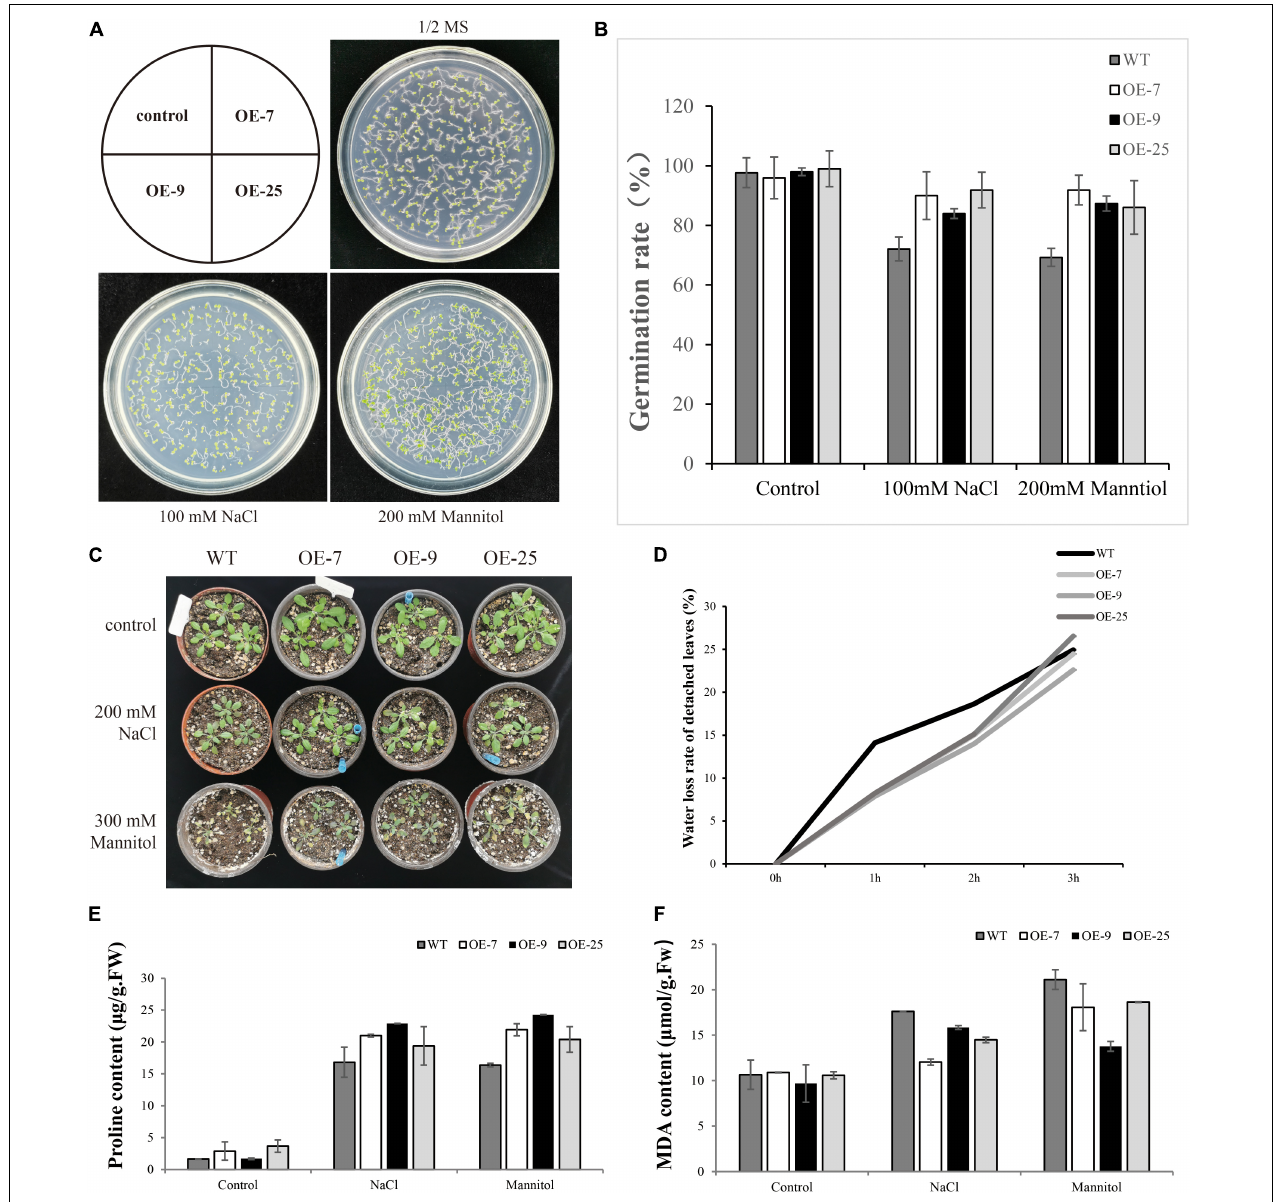
FIGURE 5 | Seed germination assays in mature seeds of WT (WT) and BpMYB4-OE lines (OE-7, OE-9, and OE-25). (A) Germination of WT, OE-7, OE-9 and OE-25 Arabidopsis seeds on 1/2 MS media, 100 mM NaCl + 1/2 MS and 200 mM mannitol + 1/2 MS. (B) Quantification of greening cotyledons on plates corresponding to (A) . (C) Growth phenotype of Arabidopsis plants. (D) Water loss rate of detached leaves. (E) Determination of Pro content in Arabidopsis plants. (F) Determination of MDA content in Arabidopsis